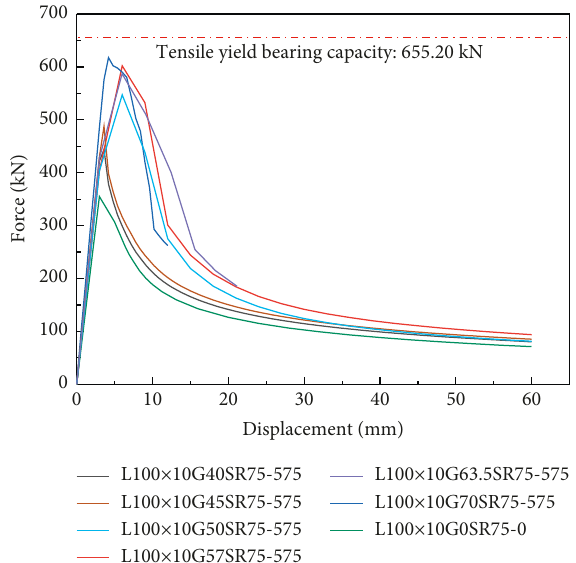
Figure 14: Effect of the different specifications of steel pipes on the